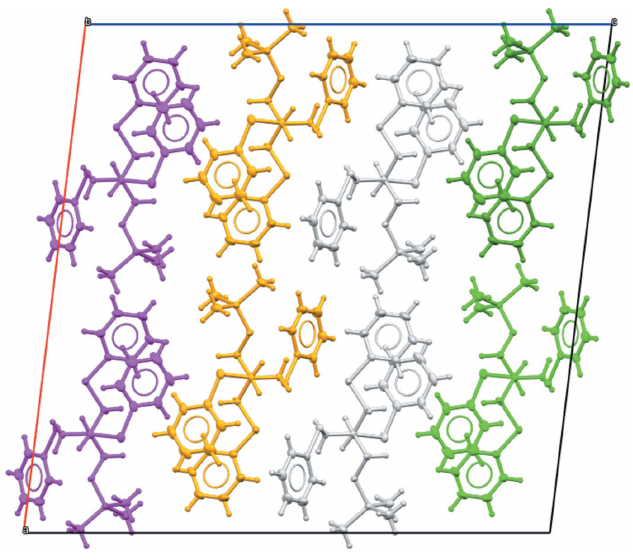
Figure 6 Crystal packing of silylated thioether ligand 3 shown along the b -axis. Molecules are coloured by their symmetry relationship to the asymmetric unit. The relationships between colour and symmetry are as follows: grey – identity; light green – twofold rotation axis; dark green – twofold screw axis; golden yellow – inversion centre; magenta – glide plane.